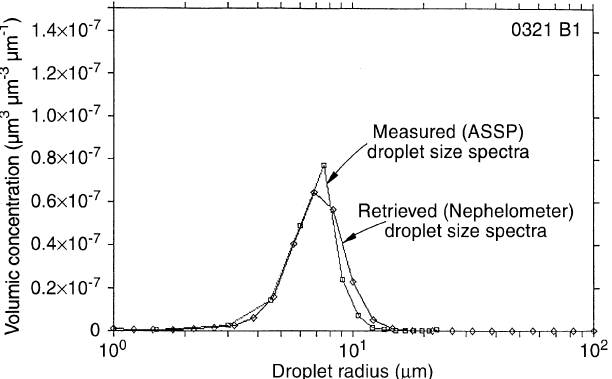
Fig. 2. Time-series of the output signal of the channel 6 ( (cid:104) (cid:136) 15 (cid:14) , see Table 3 in Gayet et al ., this issue) measured by the Polar Ne- phelometer and the mean volumic diameter (MVD), the droplet con- centration (CONC) and the liquid water content (LWC) obtained from the ASSP data